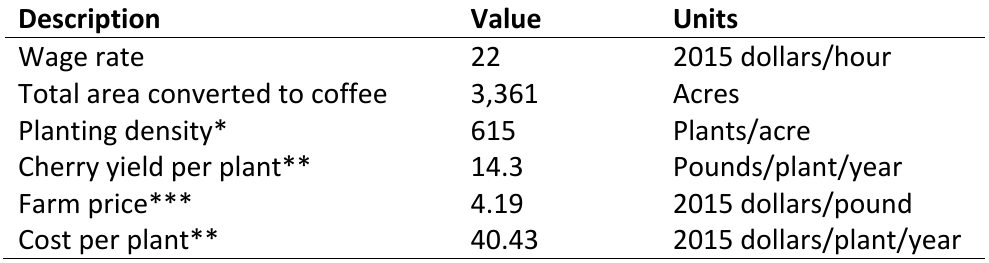
Table A1.8. Annual revenue and costs for coffee scenario (current